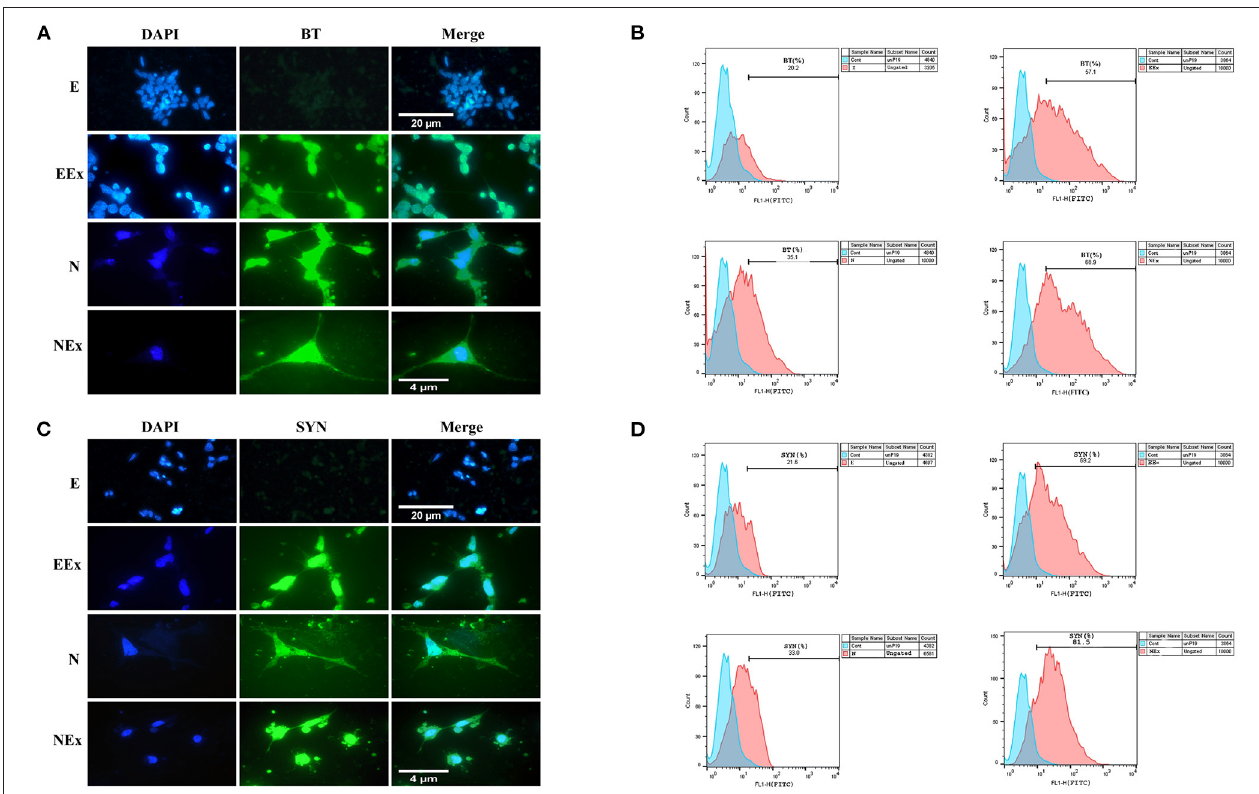
FIGURE 6 | Qualitative and quantitative assessment of neuronal-specific proteins, β -III tubulin, and synaptophysin in the second week of the differentiation protocol. (A) The cells of all groups except E were immunoreactive to β -III tubulin. (B) Flow cytometry results showed a higher level of β -III tubulin protein in NEx, EEx, and N groups compared to the E group. (C) The cells of all groups except E were immunoreactive to synaptophysin. (D) Flow cytometry results showed a higher level of synaptophysin protein in NEx, EEx, and N groups compared to the E group. DAPI was applied to counterstain the nuclei. BT, β -III tubulin; SYN, synaptophysin; E (empty), EBs transfected with pCMV3-GFPSpark vector; EEx (empty/extract), EBs transfected with pCMV3-GFPSpark vector and treated by extract; N (Nurr), EBs transfected with pCMV3-NR4A2-GFPSpark vector; NEx (Nurr/extract), EBs transfected with pCMV3-NR4A2-GFPSpark vector and treated by